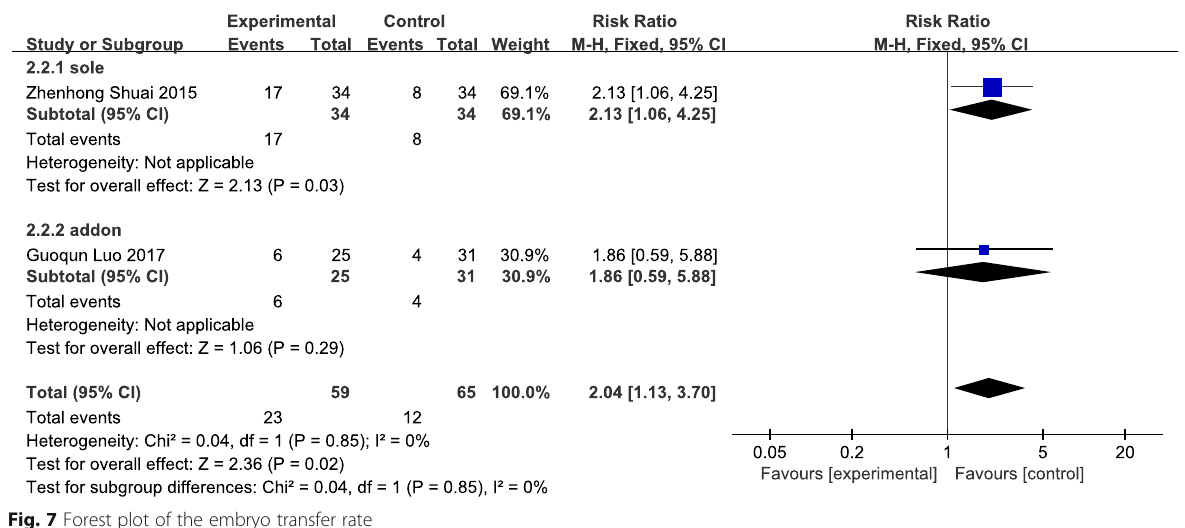
Fig. 7 Forest plot of the embryo transfer